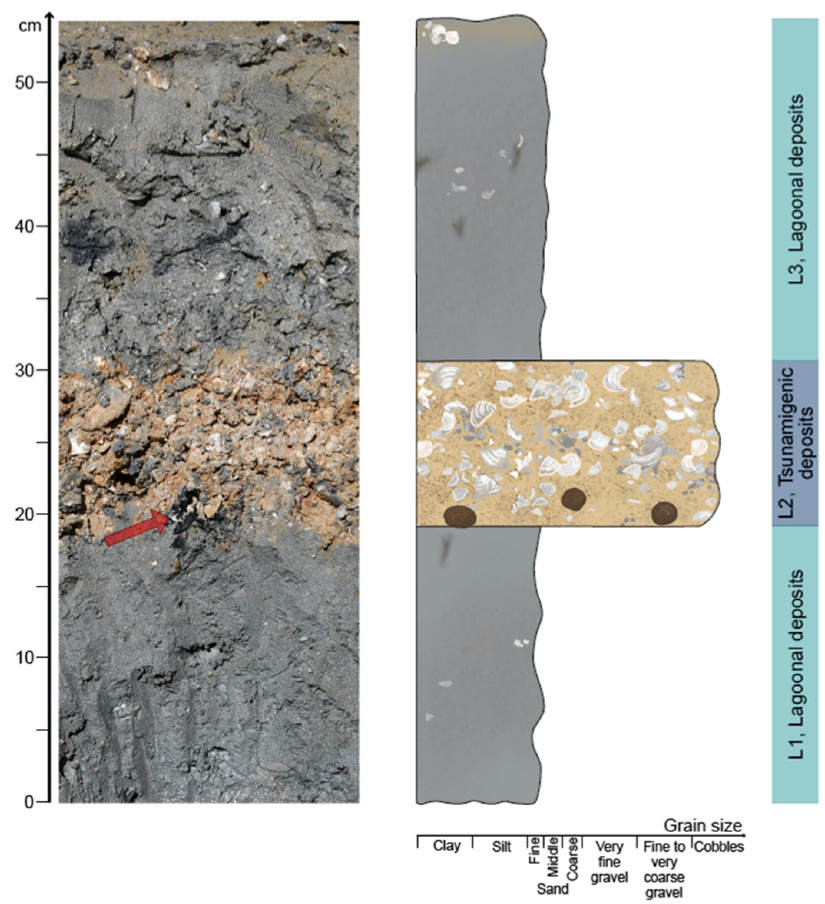
Figure 2. Vertical sections through the tsunamigenic deposits in the Sur lagoon. Left: photo of the trench. The red arrow indicates dark ‐ colored wood remains. Right: measured section. Brown circles represent woody axes at the base of the tsunamigenic layer L2.